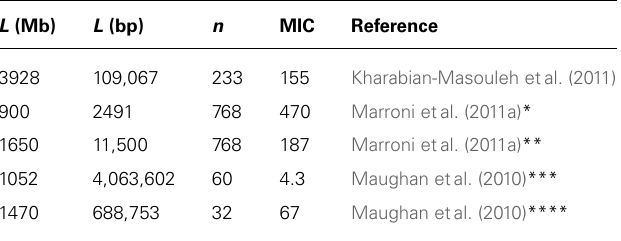
Table 2 | Summary statistics of reads and coverage obtained in three NGS